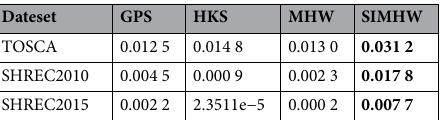
Table 1. Shape classification accuracy calculated by MHD distance, the best results are displayed in bold.